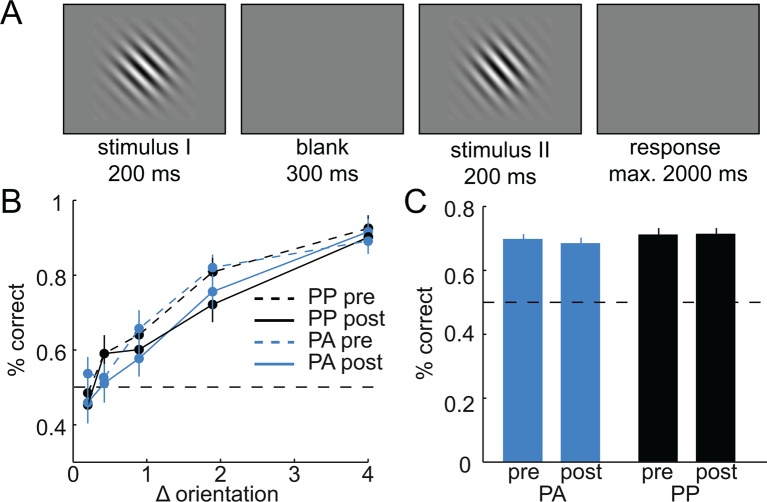
Amisulpride does not enhance perceptual discrimination performance.(A) Design and timing of the perceptual orientation discrimination task. Stimulus I was always 135°, whereas stimulus II was tilted by ± 0.2°, ± 0.4°, ± 0.9°, ± 1.9°, or ± 4°. Subjects had to indicate whether stimulus II is tilted counter-clockwise or clockwise relative to stimulus I. (B) Performance differed as a function of the difference in orientation between stimulus I and stimulus II (3-way ANOVA, F(4,172) = 74.46, P < 0.001), but not between groups (F(1,43) = 0.01, P = 0.93) or time (pre vs. post drug, F(1,43) = 2.73, P = 0.11). Importantly, there was no significant group-by-time interaction (F(1,43) = 0.07, P = 0.80). (C) Same data as in B, but collapsed across levels of orientation difference. Again, performance did not differ between groups (two-way ANOVA, F(1,43) = 0.99, P = 0.33), time (F(1,43) = 0.22, P = 0.65), and there was no significant group-by-time interaction (F(1,43) = 0.42, P = 0.52). Error bars are SEM for N = 24 (PA) and N = 21 (PP).